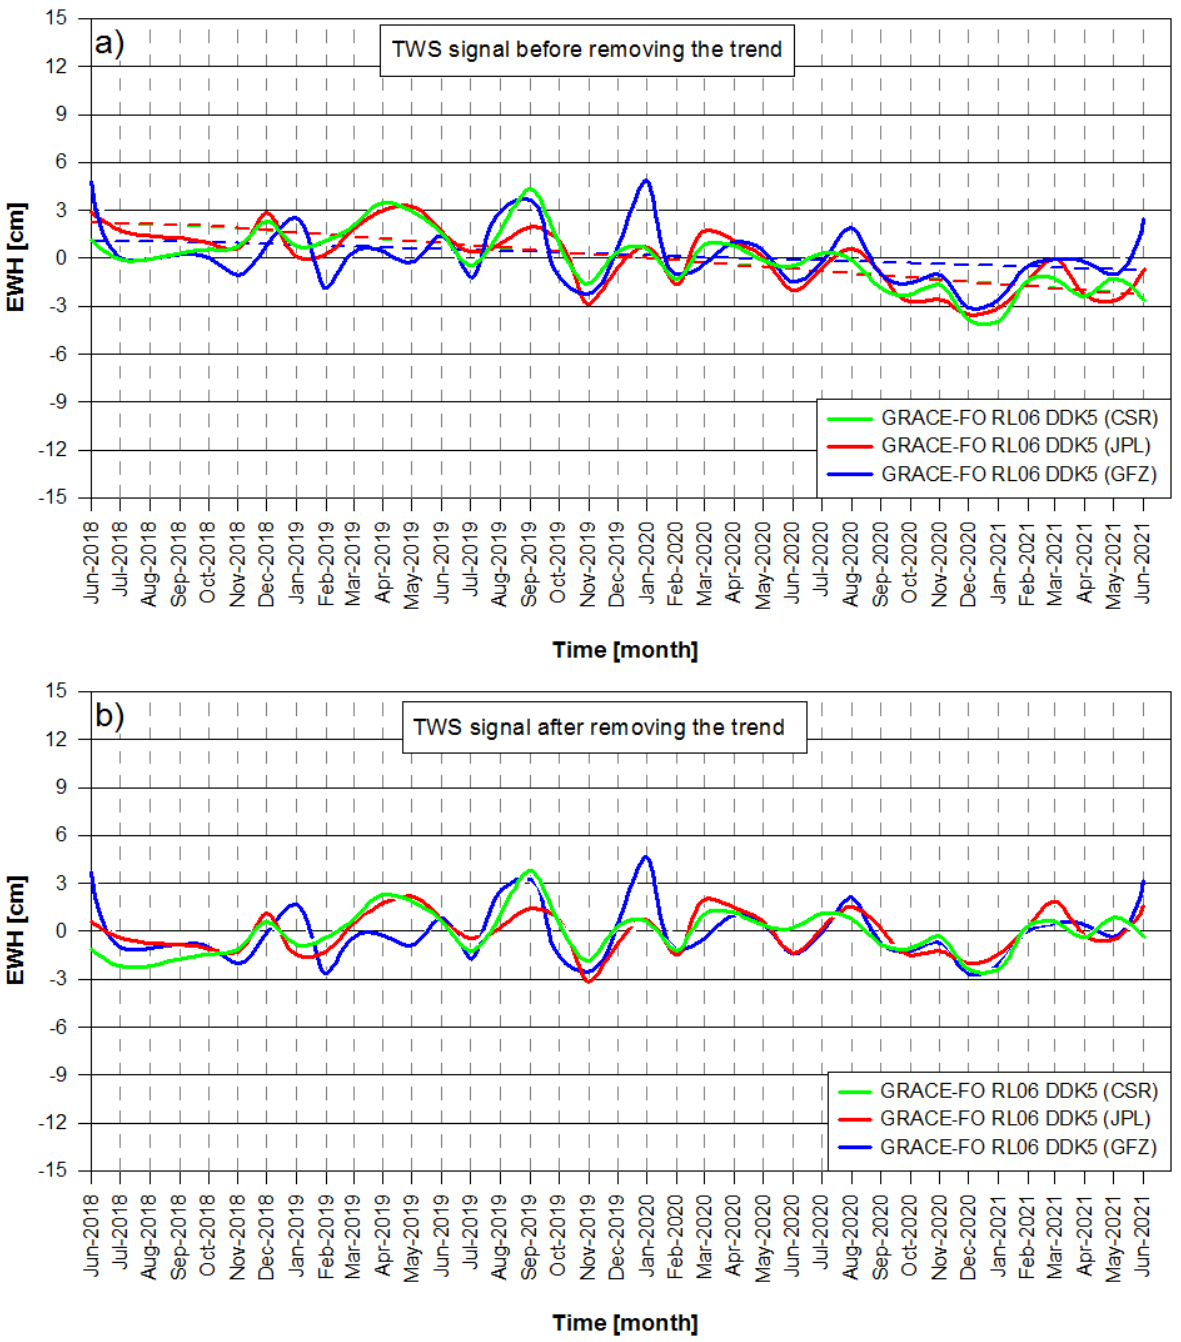
Figure 4. Mean Basin average of the TWS signal in terms of EWH [in cm] over the MAS; ( a ) before and ( b ) after removing the trend (dashed lined) as derived from the DDK5 of GRACE-FO (RL06) products from the three official centers GFZ, CSR, and JPL.